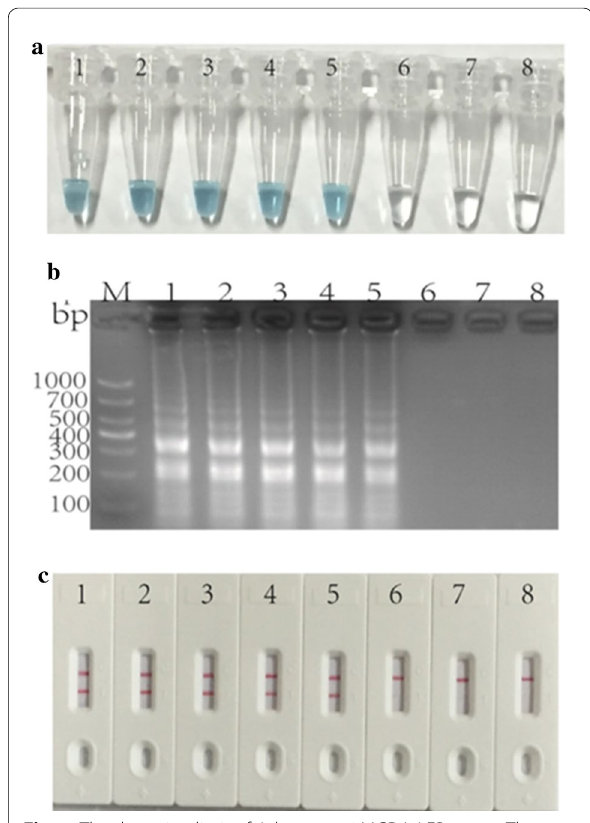
Fig. 4 The detection limit of A. baumanni -MCDA-LFB assays. Three measurement techniques, including colorimetric indicator ( a ), gel electrophoresis ( b ) and lateral flow biosensor ( c ), were applied for analysis of MCDA amplicons. Serial dilutions of the template (10 ng, 100 pg, 10 pg, 1 pg, 100 fg, 10 fg and 1 fg) were subjected to standard MCDA reactions. Tubes ( a ), lanes ( b ), biosensors ( c ) 1–8 respectively represent A. baumannii strain ATCC19606 DNA levels of 10 ng, 100 pg, 10 pg, 1 pg, 100 fg, 10 fg and 1 fg per reaction, and a blank